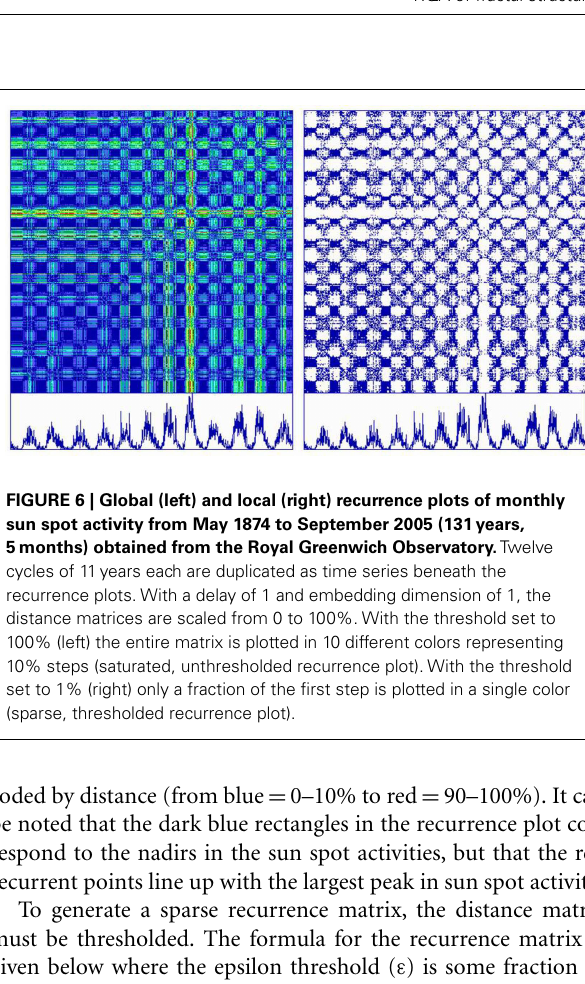
coded by distance (from blue = 0–10% to red = 90–100%). It